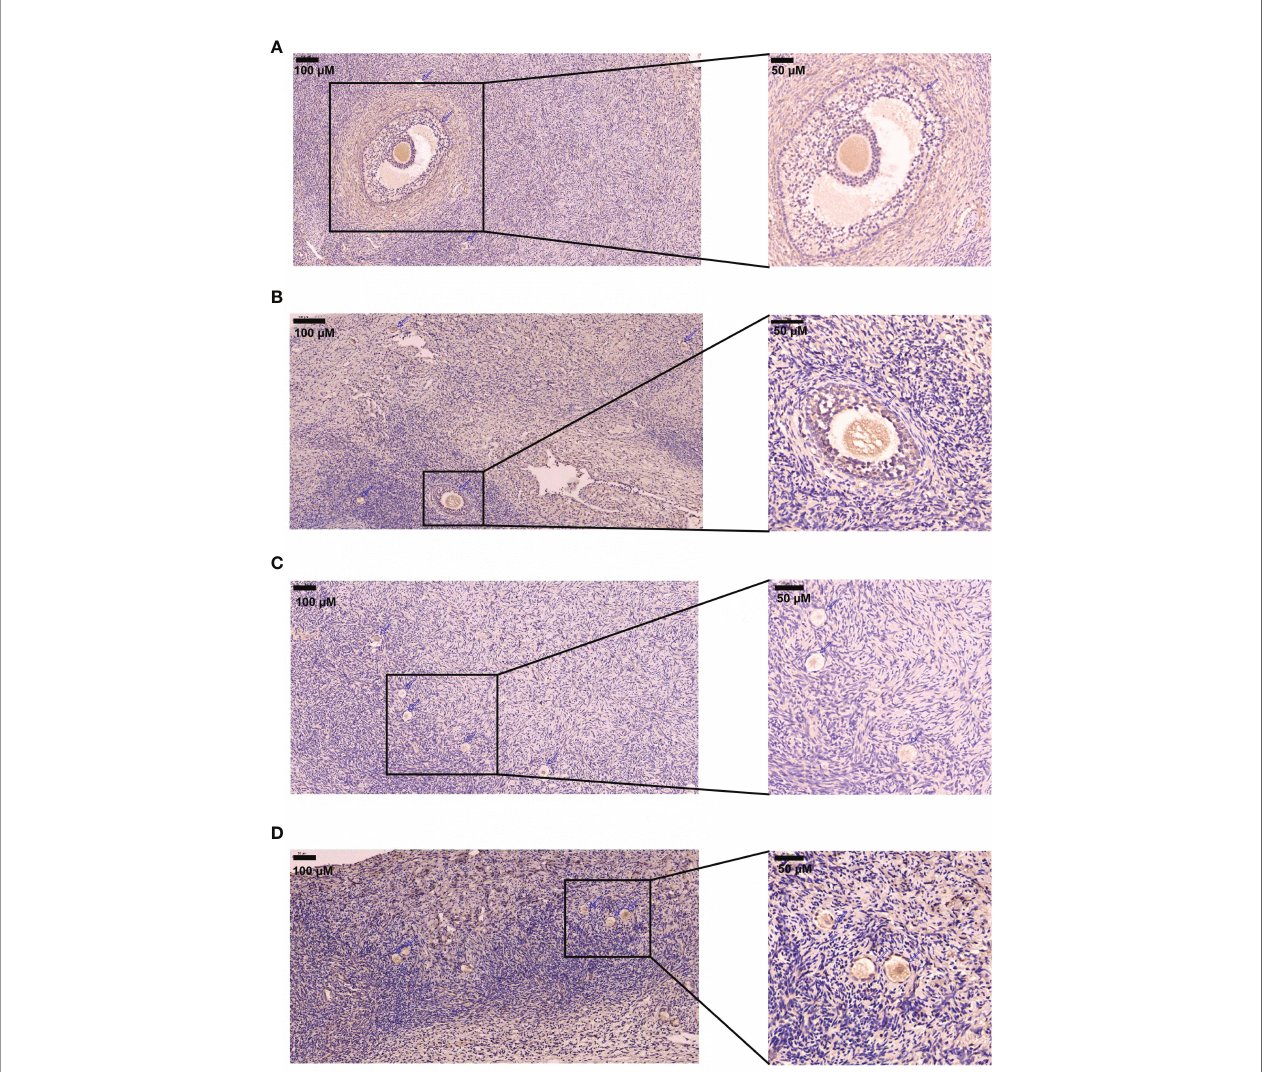
FIGURE 5 | Immunostaining analysis of DLGAP5 in the ovarian tissues. (A) Immunostaining of DLGAP5 in control group. Scale bar = 200 µm. (B) Immunostaining of DLGAP5 in PCOS group. Scale bar = 200 µm. (C) Immunostaining of DLGAP5 in control group. Scale bar = 200 µm. (D) Immunostaining of DLGAP5 in PCOS group. Scale bar = 200 µm. Blue arrows indicate primary or antral